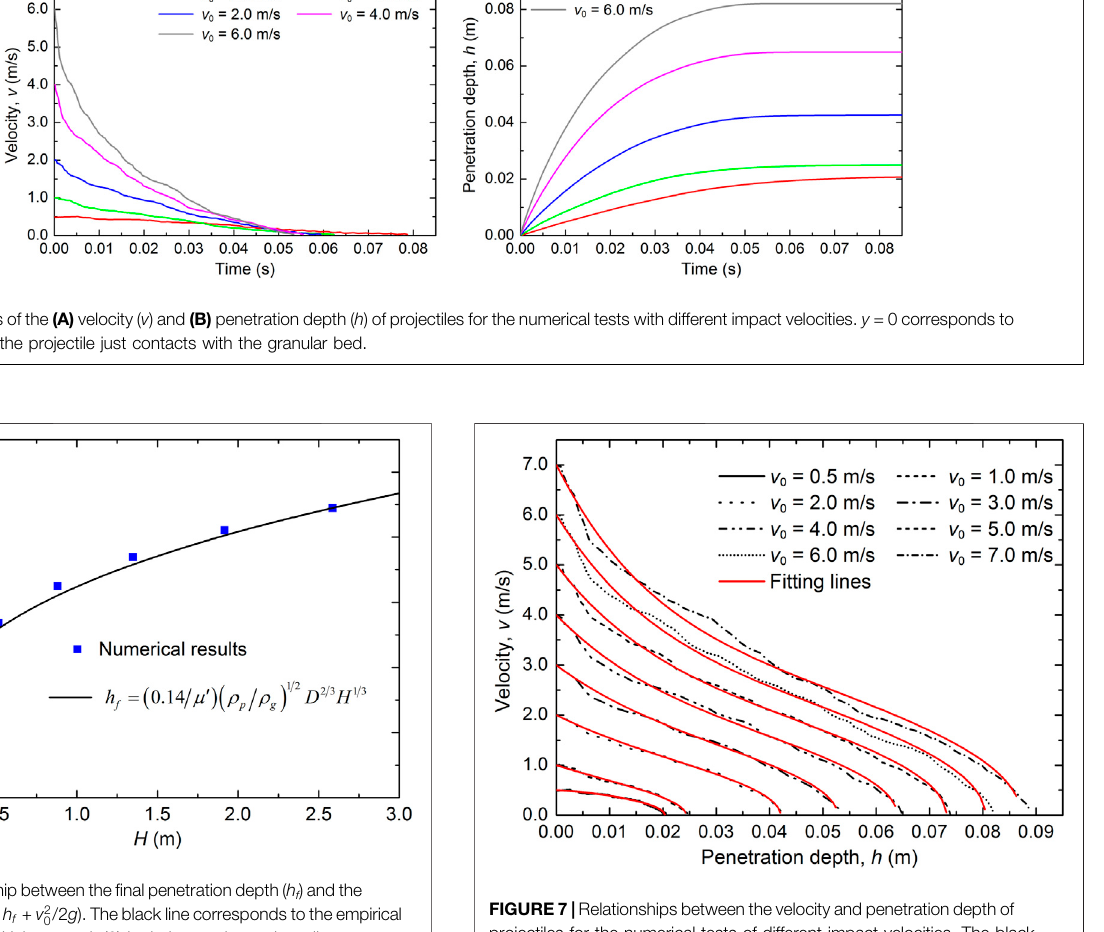
FIGURE7| Relationshipsbetweenthevelocity andpenetrationdepthof projectiles for the numerical tests of different impact velocities. The black curves represent the numerical results and the red curves are obtained by fi tting the numerical results using Eq. 9 .